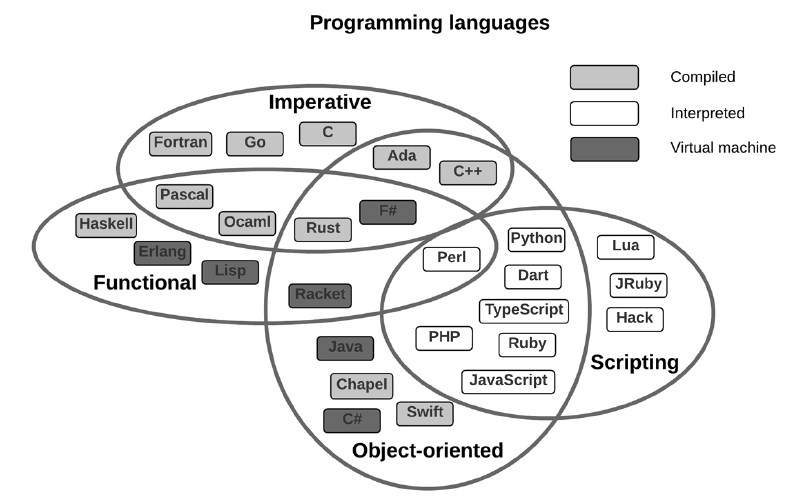
Figure 3. Classification of programming languages based on the paradigm and processing principle.